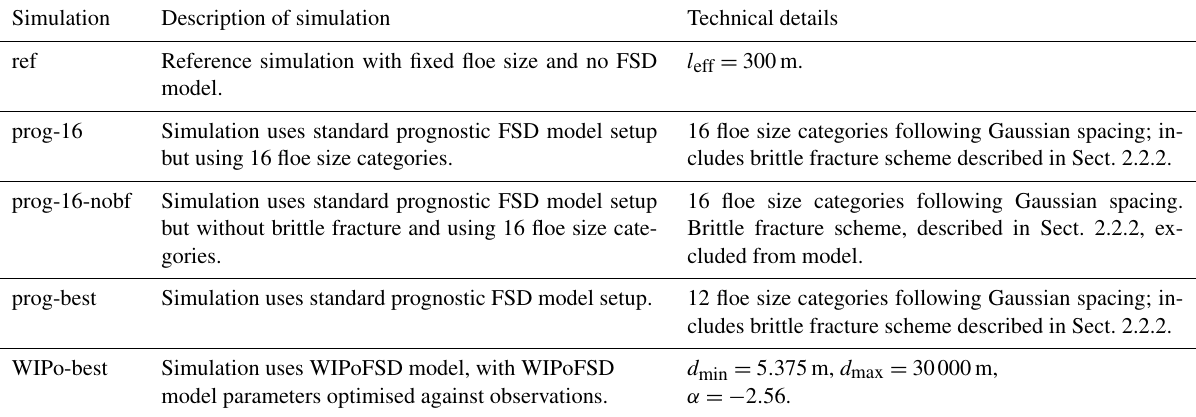
Table 2. A summary of the CPOM CICE simulations described in Sect. 3.1. All simulations are initiated sea ice free on 1 January 1980 and evaluated until 31 December